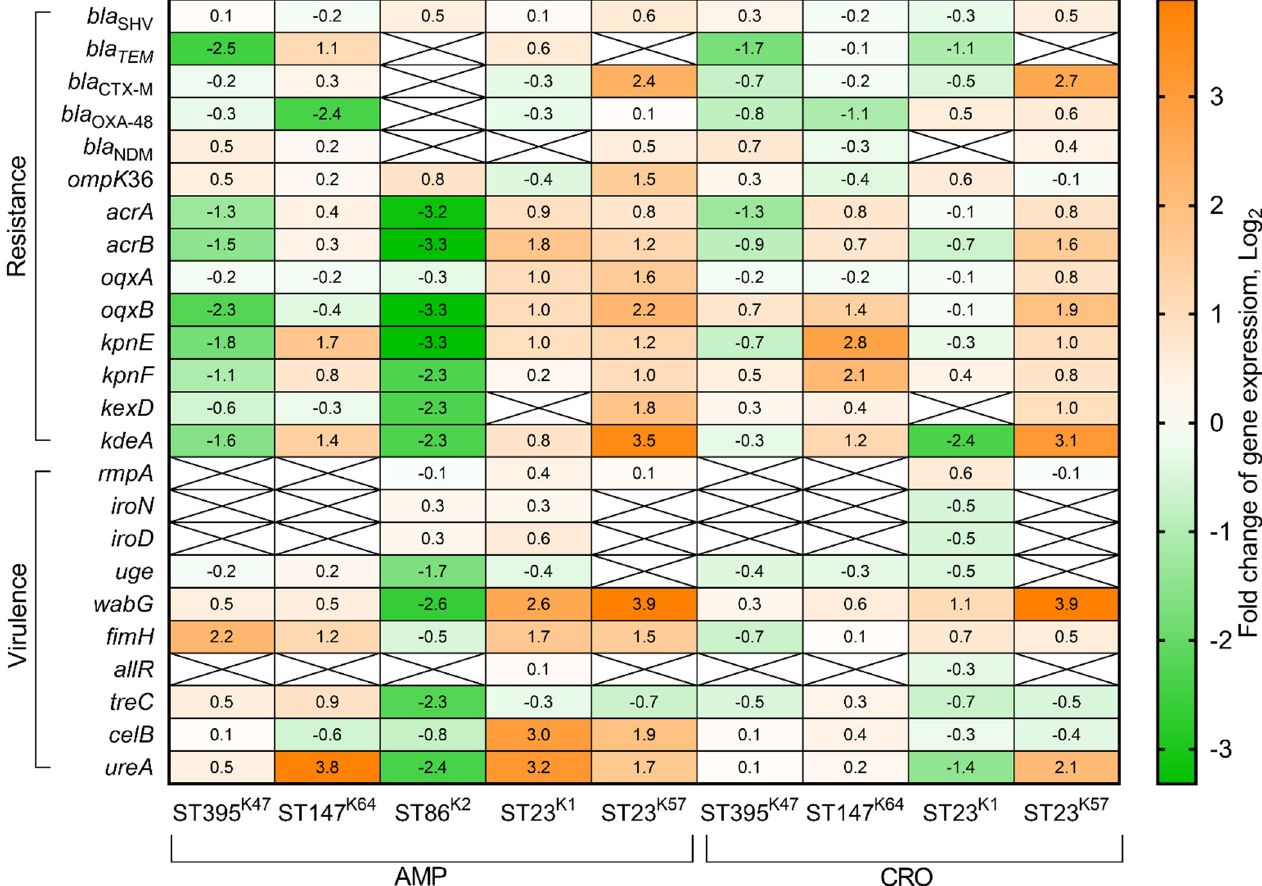
Figure 4. Heatmap of changes in gene expression levels of K. pneumoniae resistance and virulence genes under ampicillin (100 mg/L) and ceftriaxone (10 mg/L) selective pressure during 90 min in LB medium in comparison with expression levels of these genes in LB medium without antibiotics. Values of each cell represent log 2 of gene expression fold changes (fold changes ≥ 1 or ≤− 1 are signif- icant).